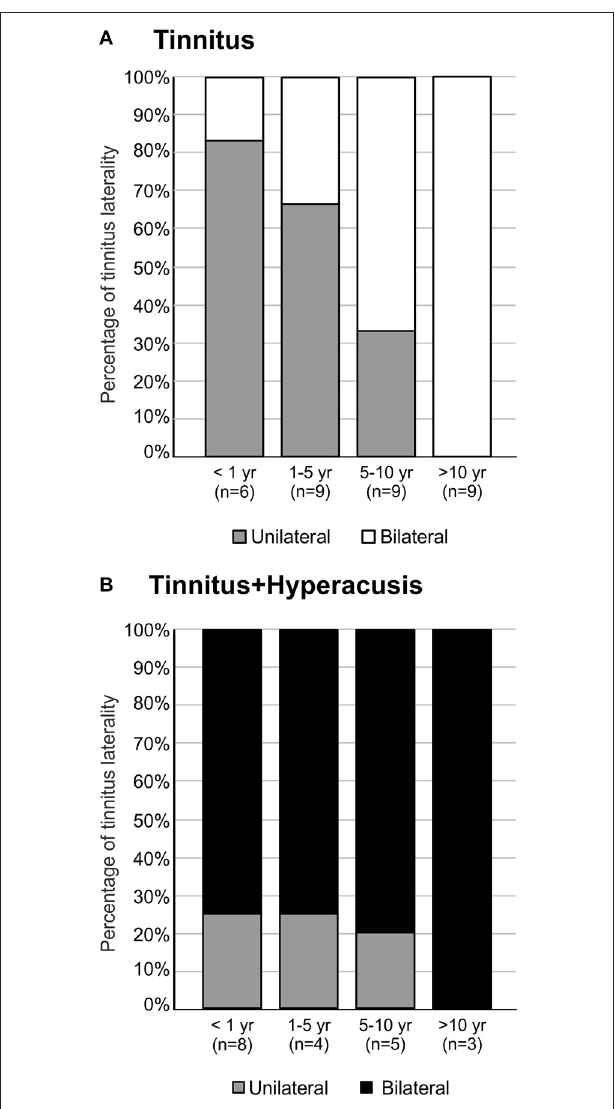
FIGURE 5 | Tinnitus laterality ends in bilateral percepts with time of persistence (duration > 10 years). (A) The majority of participants with tinnitus experience tinnitus unilateral if tinnitus duration was < 5 years. Above 5 years, most participants experienced bilateral tinnitus (Chi-Square Test, P = 0.004). (B) Participants with tinnitus + hyperacusis experienced more bilateral tinnitus independent of tinnitus duration, ending in complete bilaterality of tinnitus for durations longer than 10 years (Chi-Square Test, P =